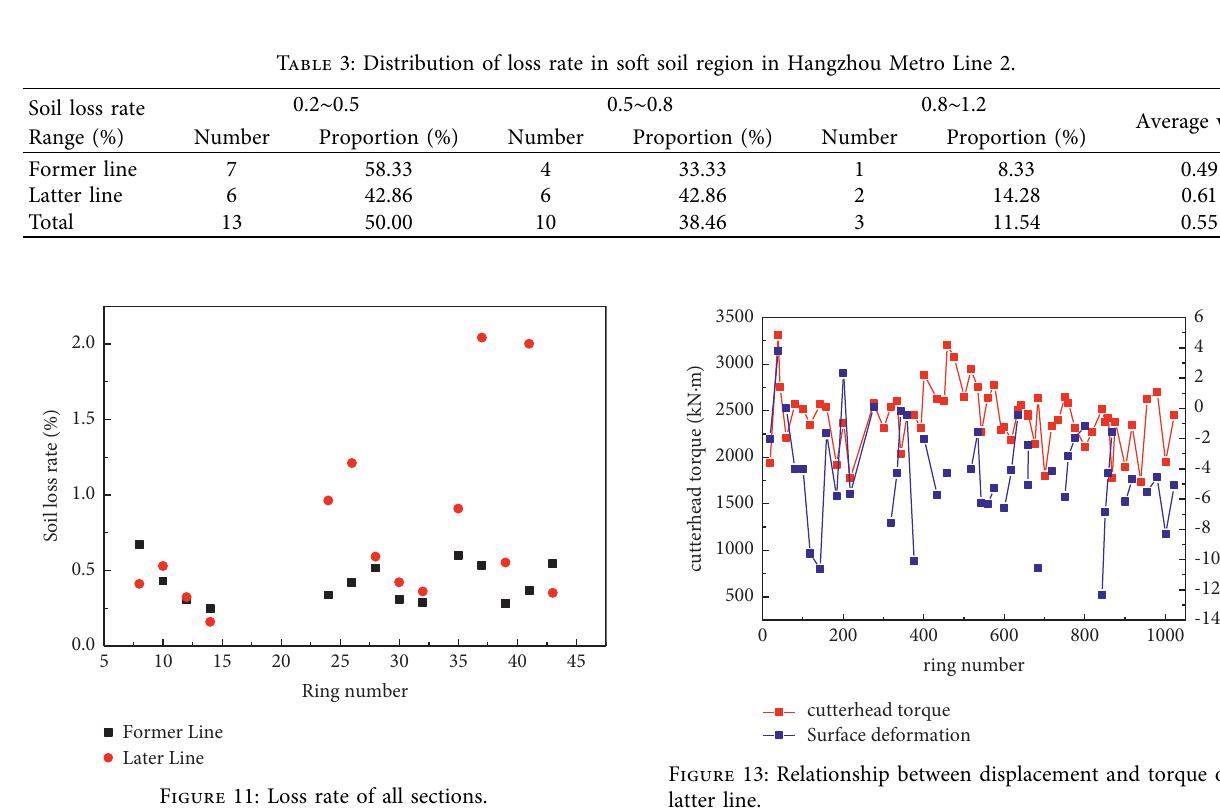
Figure 11: Loss rate of all sections.